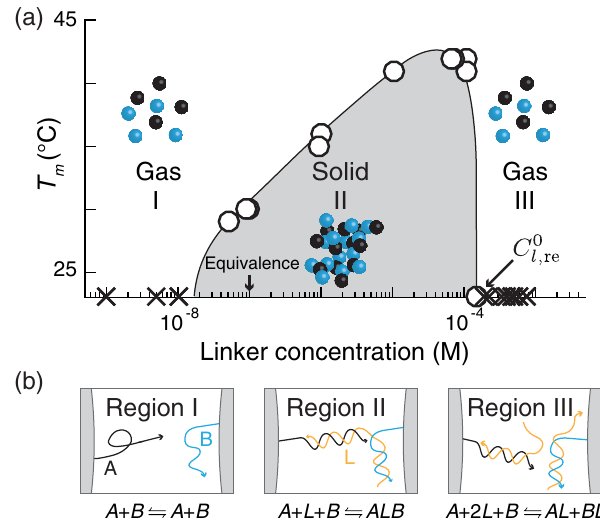
FIG. 2. Phase behavior of linker-mediated assembly. (a) The temperature-linker concentration phase diagram is characterized by three distinct regimes: a gas phase at low linker concentrations (region I), a solid-gas transition at intermediate linker concen- trations (region II), and a reentrant gas phase at the highest linker concentrations (region III). Circles show measurements of the melting temperatures at different linker concentrations; x ’ s show samples that are gas at all temperatures. We define the reentrant concentration C 0 l; as the linker concentration above which the re solid melts. The arrow labeled “ equivalence ” shows the linker concentration at which there is one linker molecule per grafted molecule in the system. Data are for the 17-nt linker and particles with a DNA grafting density of 2000 DNA = μ m 2 . The curve is a guide to the eye. We hypothesize that the phase behavior in (a) results from the molecular-scale reactions shown in (b).